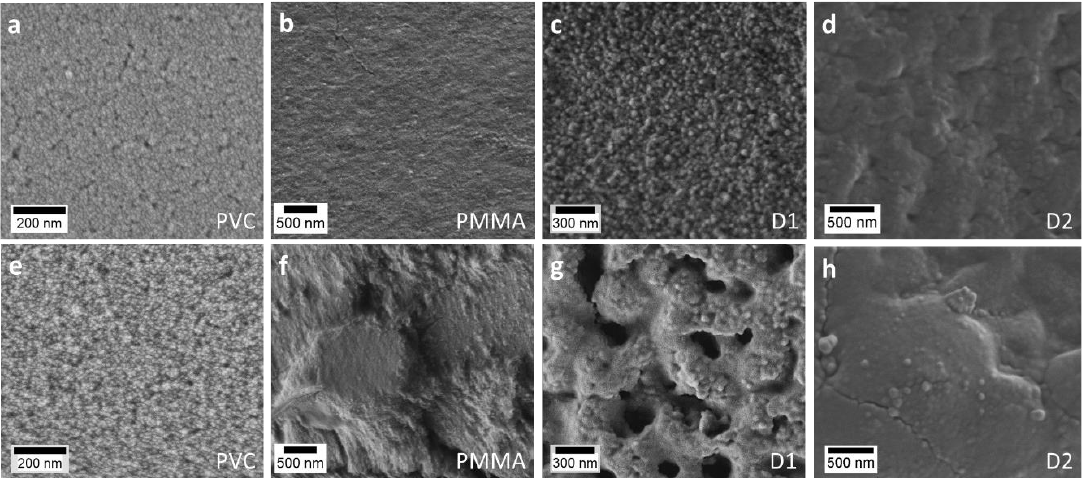
Figure 5. Typical scanning electron microscopy (SEM) images of Ti0Zr film ( a – d ) and Ti10Zr film ( e – h ) on four different substrates: PVC_s ( a , e ), PMMA ( b , f ), D1 ( c , g ), and D2 ( d , h ).